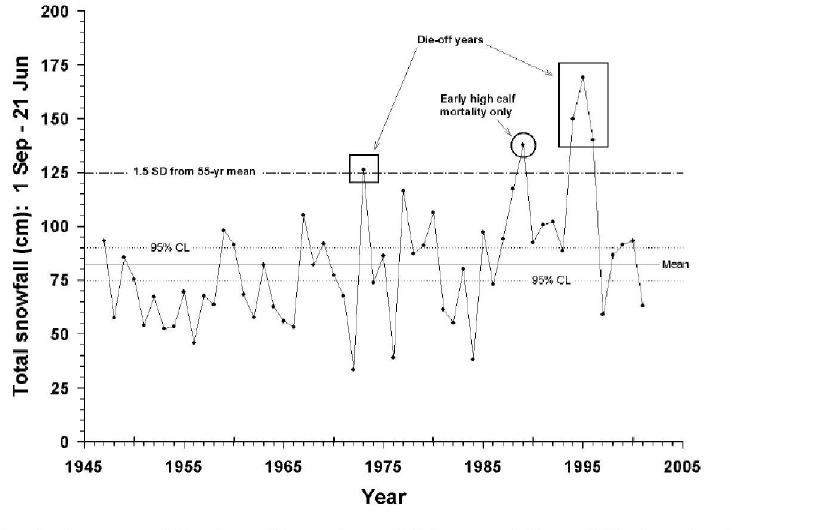
Fig. 4. Long-term (55-yr) trend in total snowfall between 1 Sep and 21 Jun of each caribou-year (1 Jul-30 Jun, 1947/48-2001/02) at Resolute Airport (74°43'N, 94°59'W), Cornwallis Island, Canadian High Arctic: showing highest total snowfalls associated with the four major die-off years (1973/74, 1994/95, 1995/96 and 1996/97) and the one year